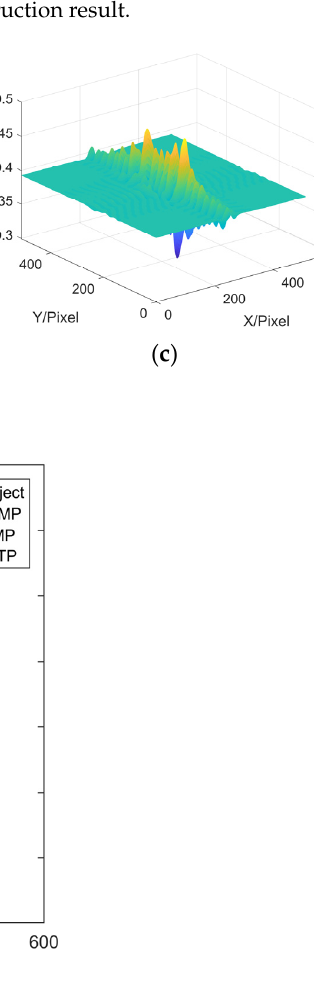
Figure 5. The cutaway of the 250th column. Table 1. Comparison of experimental results.